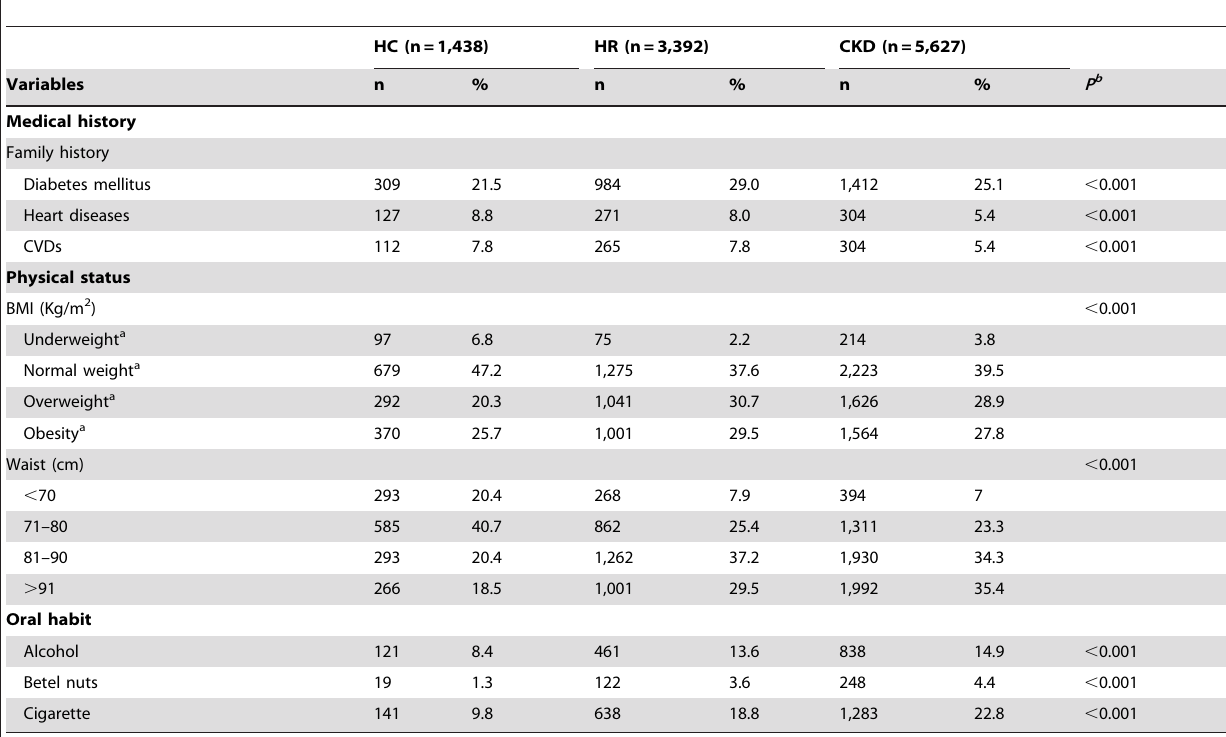
Table 2. Medical history, anthropometric measurements and oral habits of eligible